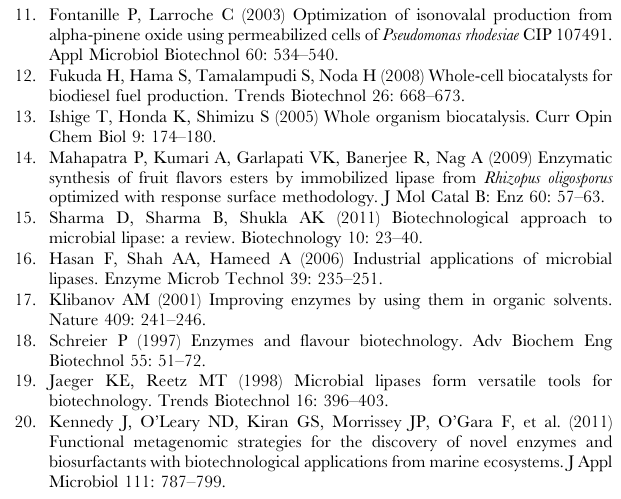
Figure S1 SDS-PAGE (A) and zymogram (B) of purified recombinant LipIAF5-2. Lane 1: Precision Plus All Blue molecular weight standard (Bio-Rad). Lane 2: Soluble fraction of control strain harboring vector pET16b. Lanes 3: soluble fraction of E. coli strain harboring pET16b-F52. Lane 4: Purified LipIAF5- 2 after IMAC chromatography. The equivalent of 5 m g of purified enzymes were loaded in lane 4. (TIF) Figure S2 Fluidized bed reactor scheme. See Materials and Methods for details.